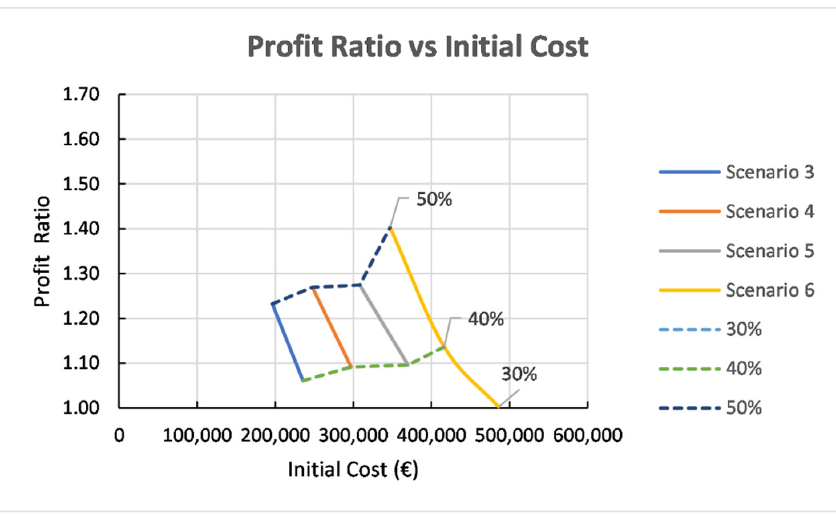
Figure 14. Effect of subsidy to PR and the initial cost of the HRS.